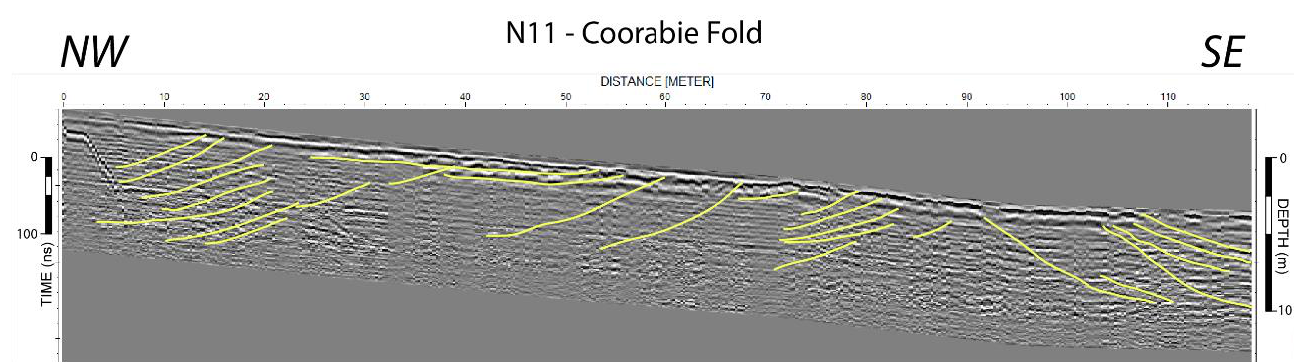
Figure 14. ( A , B ): GPR transect N11, interpreted reflectors shown in yellow. Figure 14. GPR transect N11, interpreted reflectors shown in